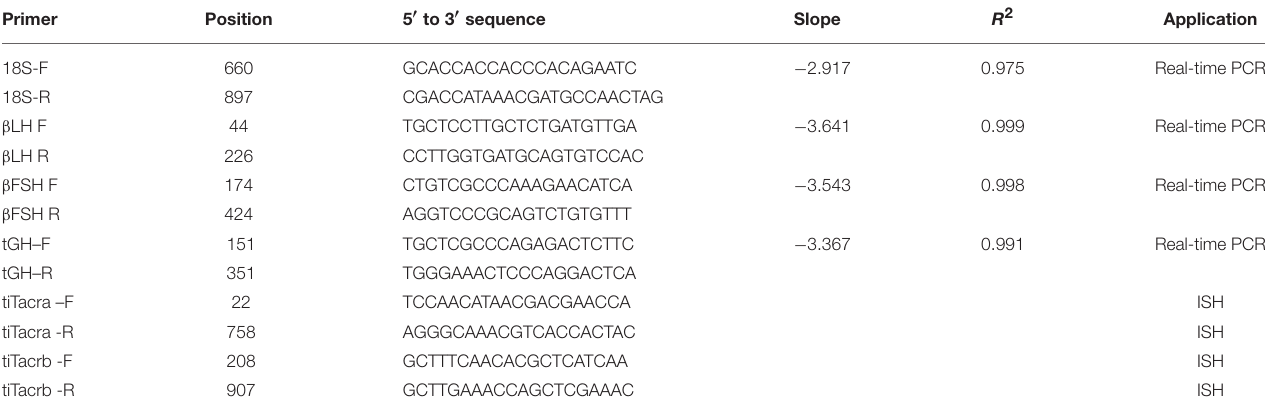
TABLE 1 | Primers used for quantitative real-time PCR and in situ hybridization. Primer 5 ′ to 3 ′ sequence Slope R